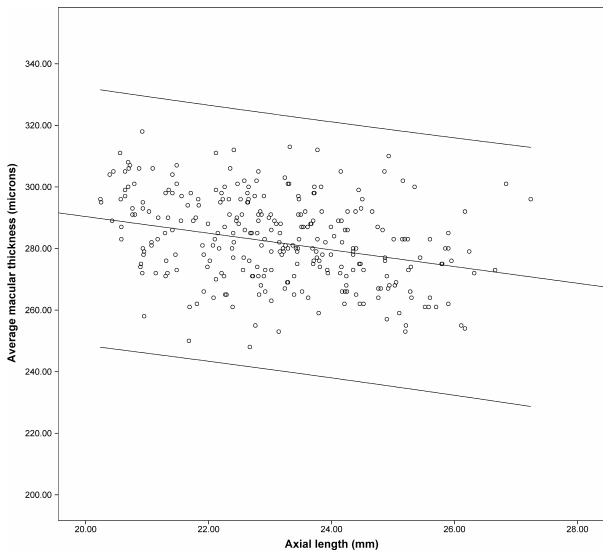
Fig. 2. Correlation between average macular thickness (m (cid:1) ) and AL